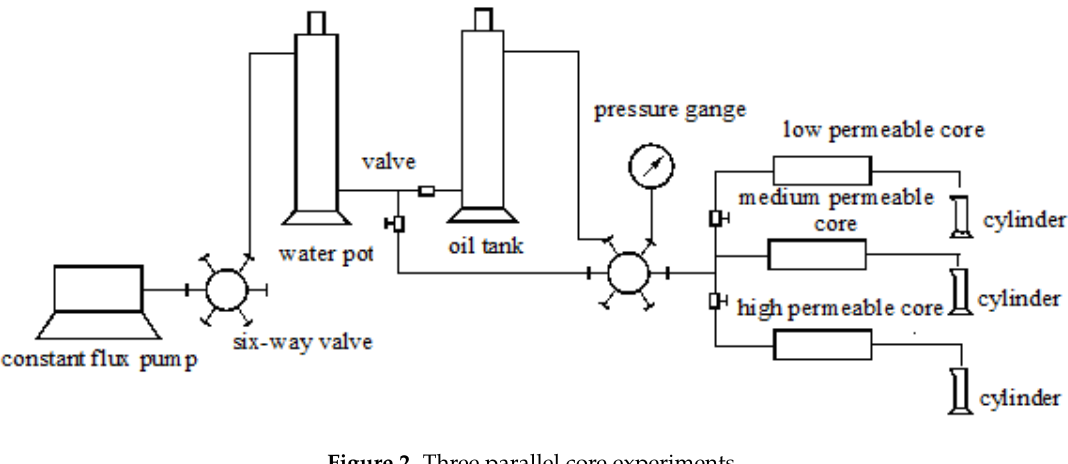
Figure 2. Three parallel core experiments.